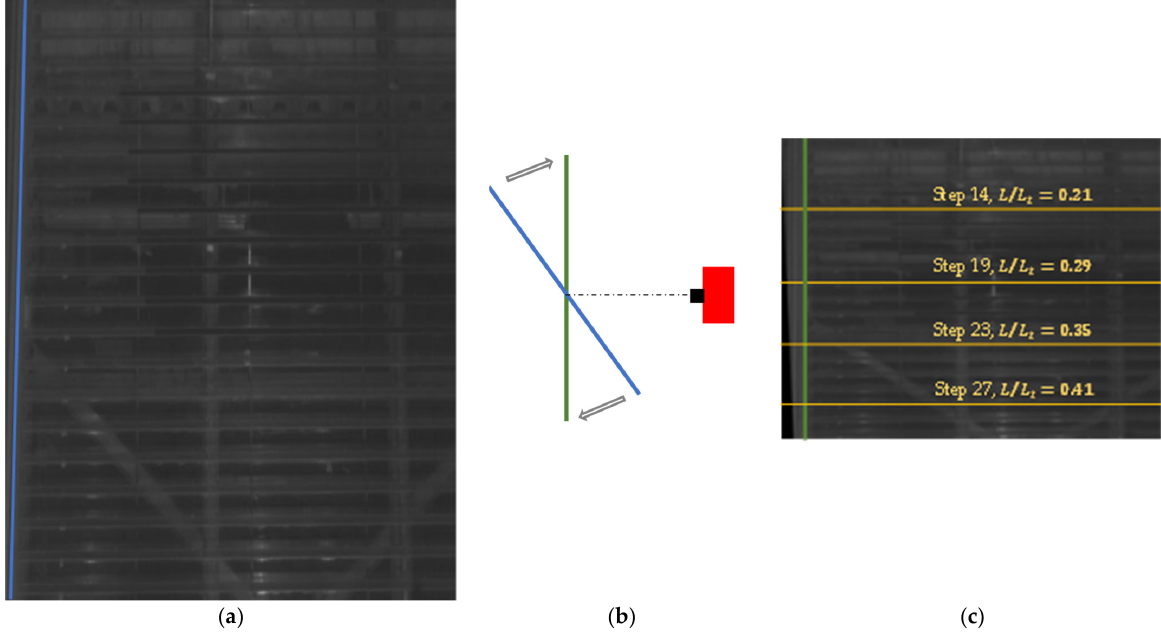
Figure 4. ( a ) Original frame #0001 of video 0 (without water, 200 fps); the blue line is the foot of the right sidewall of the chute. ( b ) Image folding (profile view). ( c ) Folded original frame #0001 of video 0; the green line represents the foot of the folded right sidewall of the chute.